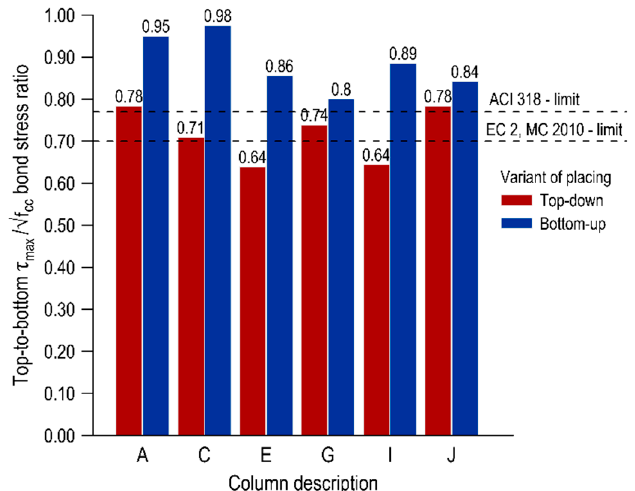
Figure 5. Top-to-bottom ratio for normalized ultimate bond stresses.